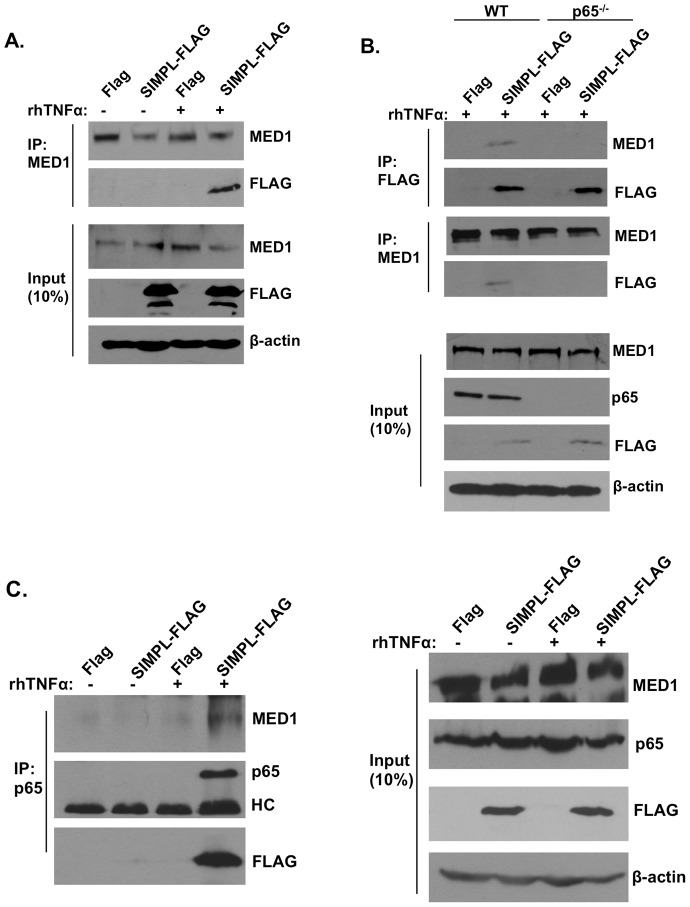
TNFα induced formation of SIMPL-MED1 complexes is p65 dependent.(A) HEK 293 cells or (B) wild-type MEFs or MEFs lacking p65 were transfected with SIMPL-FLAG or empty FLAG-vector, 72 h later cells were left untreated (-) or treated with rhTNFα (10 ng/ml) for 45 min. Upper panels: immunocomplexing assays were performed with antibody to MED1 (IP:MED1) and/or FLAG (IP:FLAG) and immunocomplexed materials were subjected to Western analysis with the antibody to the proteins indicated on the right hand side of the figure. Lower panels: Cell lysates (50 ug) used in immunocomplexing assays were subjected to Western analysis with antibodies to the indicated proteins. (C) HEK 293 cells were transfected with the indicated constructs, 72 h later cells were left untreated or treated with rhTNFα (10 ng/ml) for 45 min. Cell lysates were either analyzed directly (panel labeled input) or were subjected to immunocomplexing assays with Flag-antibody coupled sepharose beads, materials bound to the agaroase beads were eluted with Flag peptide and subjected to immunocomplexing assays with antibody to p65. Immunocomplexed materials were subjected to Western analysis with the antibodies to the proteins indicated on the right hand side of the figure. All assays were repeated at least three times.